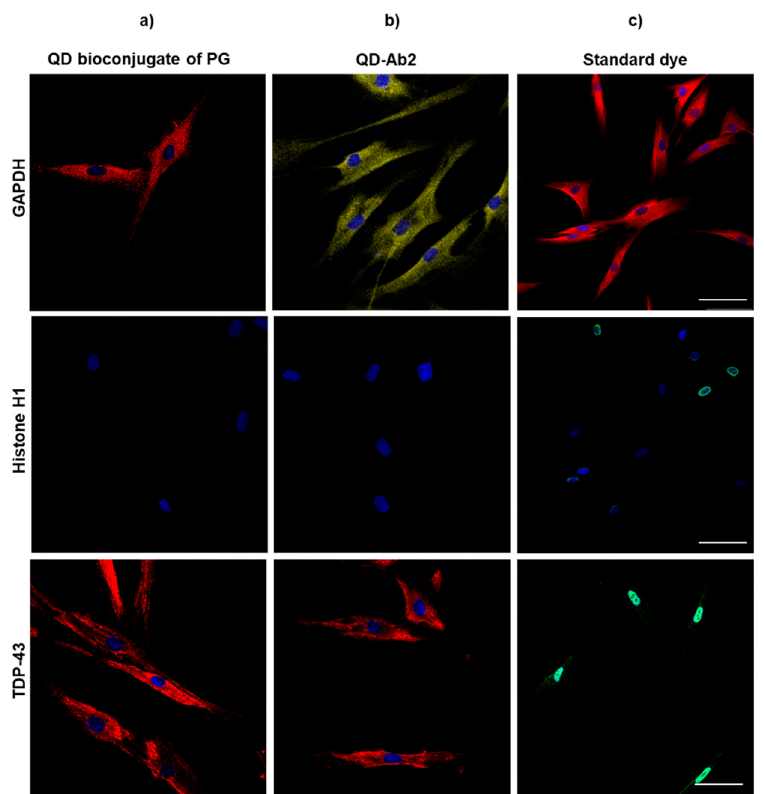
Figure 7. GAPDH, Histone H1 and TDP-43 labelling with different commercially available QD conjugates and classic IF in fibroblasts from an ALS patient. GAPDH, Histone H1 and TDP-43 were stained in a one-step protocol with ( a ) QD655 bioconjugate of PG incubated with primary antibody or in a two-step protocol with ( b ) QD655-Ab2 after primary antibody incubation and ( c ) standard dye after primary antibody incubation. For labelling cytoplasmic targets Triton 0.25% was used as permeabilization reagent in all cases. No nuclear staining was achieved with QD bioconjugates even using further permabilization with PK 30 µ g/mL. Nuclei were stained with HCS Nuclear Mask Deep Red. Scale bar: 20 µ